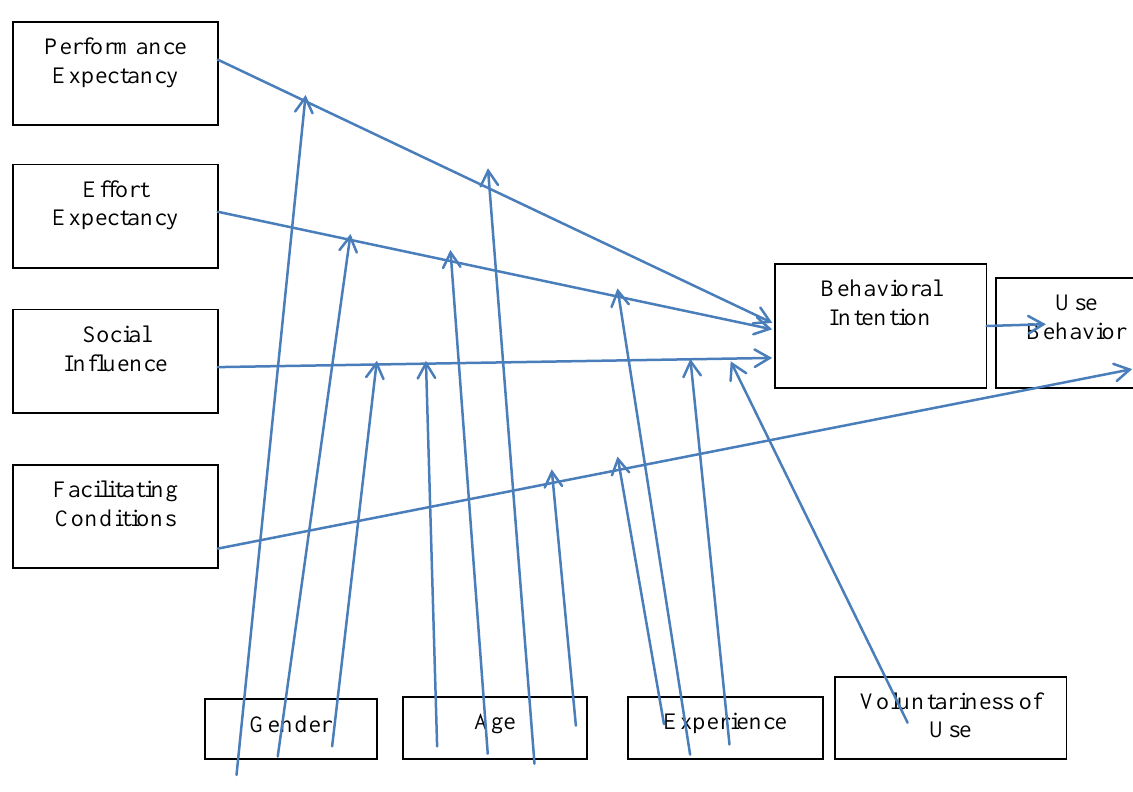
Figure 2 . The unified theory of acceptance and use of technology (UTAUT) model (Venkatesh et al.,